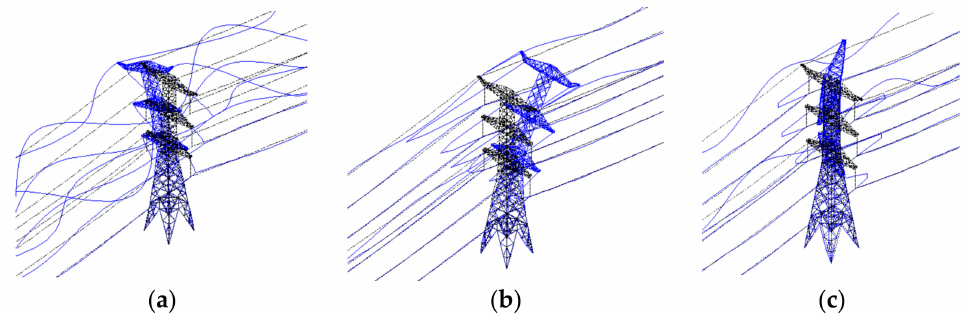
Figure 4. Vibration modes of a tower-line system: ( a ) first mode, 0.8669 Hz; ( b )second mode, 0.9271 Hz; ( c ) third mode, 1.3209